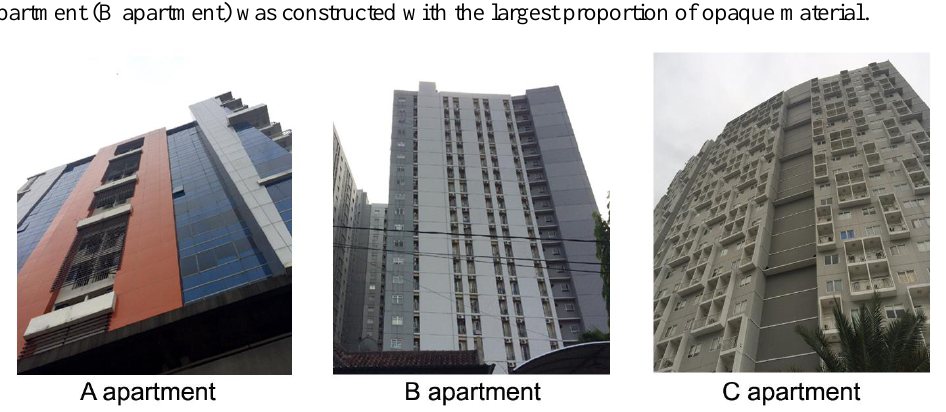
Fig. 1. Façade of High Point (A), Gunawangsa (B), and Universitas Ciputra (C) apartments (from left to right).